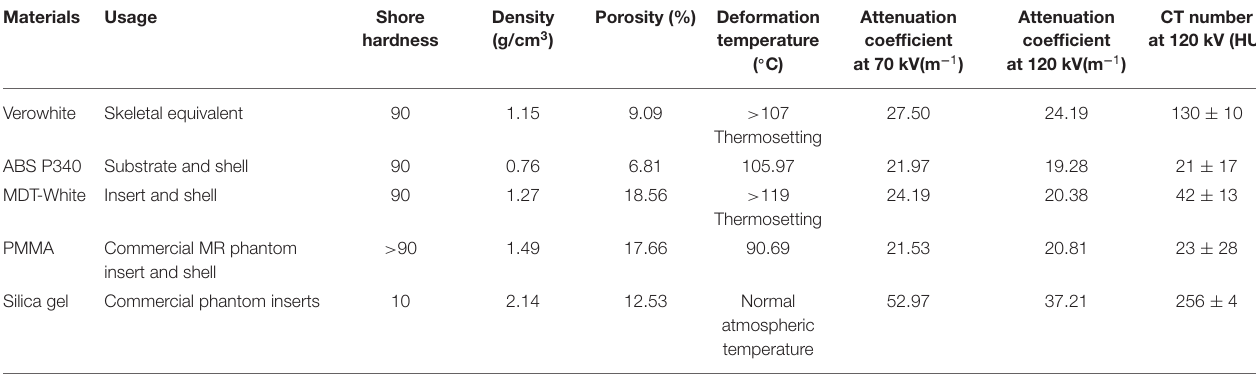
TABLE 1 | Physical and medical imaging characteristics.